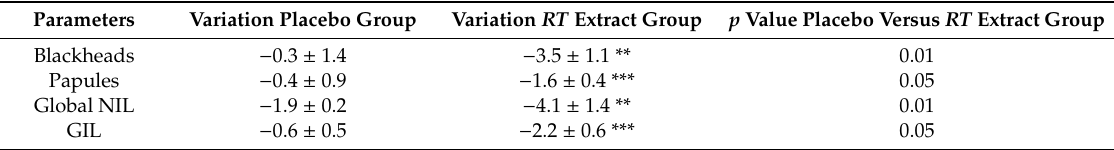
Table 2. Inflammatory and non-inflammatory lesion variations between D0 and D28 for the placebo and RT extract